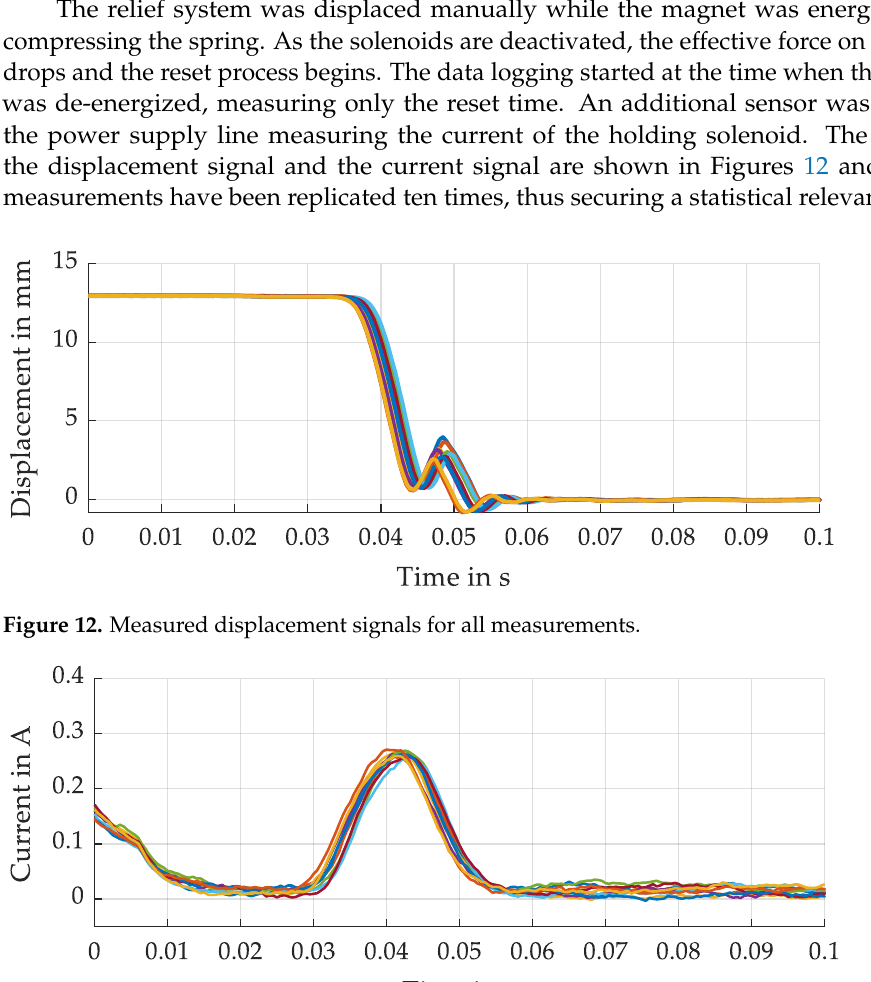
Figure 11. The systematical measuring set up.